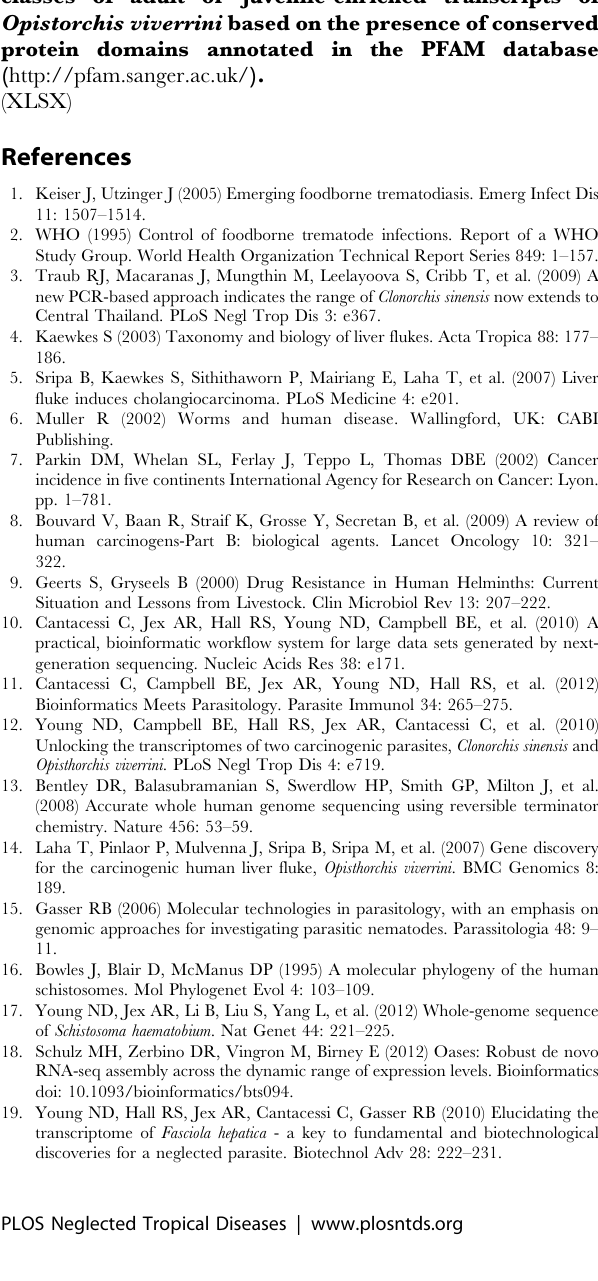
Table S7 Summary of the peptidases characterized in the Opistorchis viverrini transcriptome based on ho- mology to proteins in the MEROPS database ( http:// merops.sanger.ac.uk/ ) and information on their levels of transcription in juvenile and adult stages of this parasite. Table S8 Summary of annotation information available for transcripts present in the 454-only assembly but with no homologue in the 454 + Illumina assemble of the Opistorchis viverrini transcriptome. Table S9 Summary of the number of 454 and Illumina reads respectively mapping to each transcript in the 454-only and 454 + Illumina transcriptome assemblies for Opistorchis viverrini